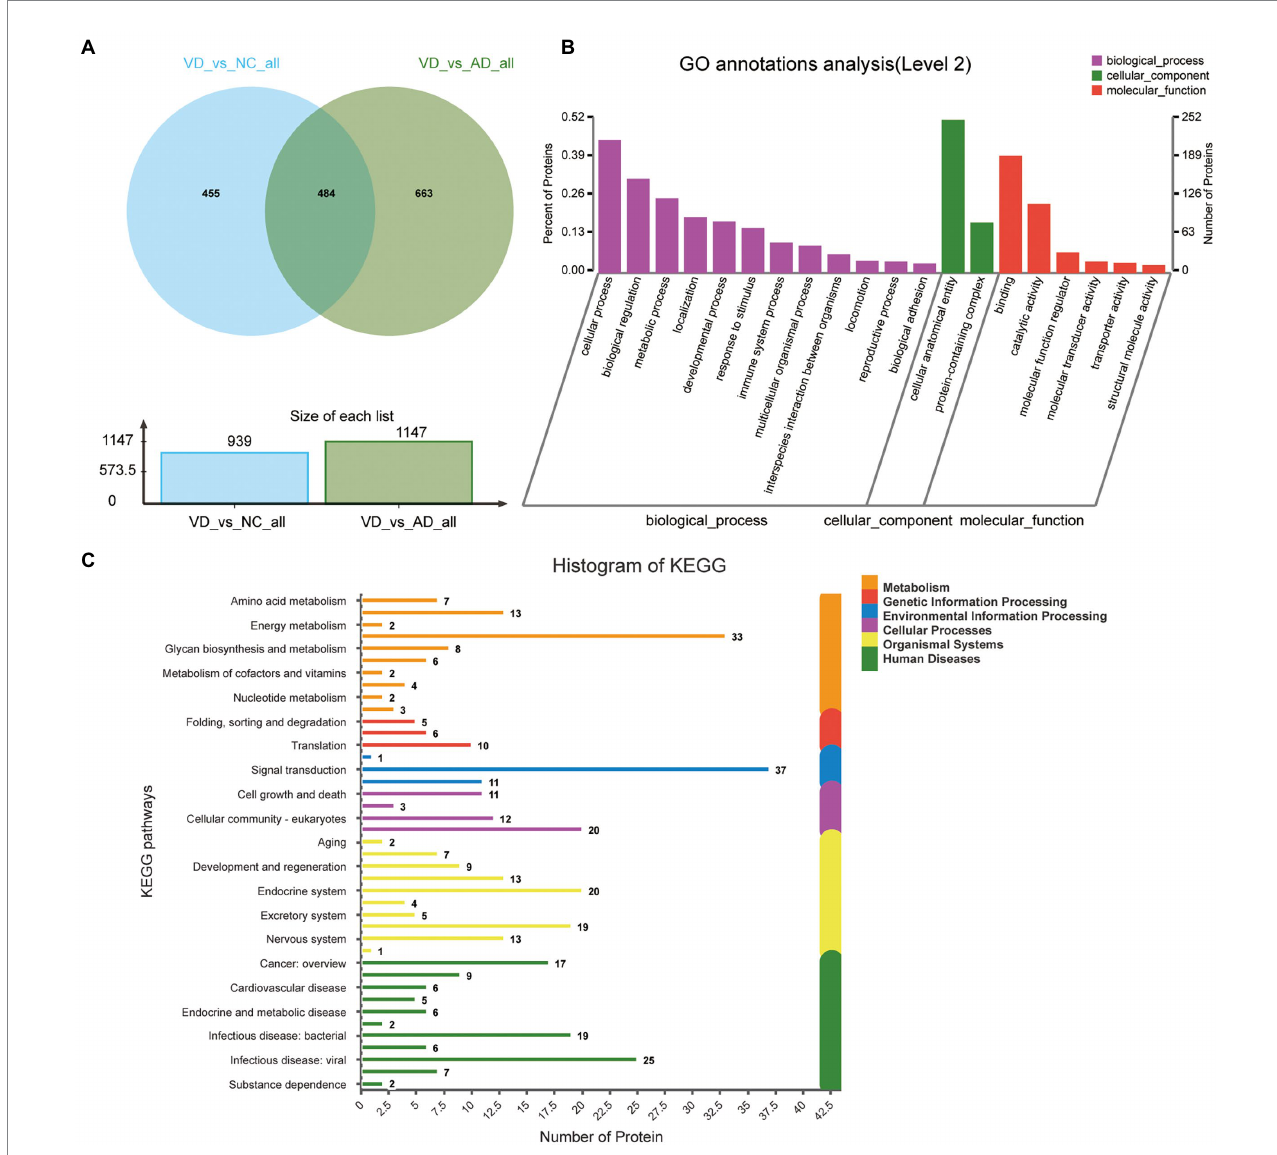
FIGURE 5 Volcano plots of quantified proteins and functional analysis of the differential expressed proteins in urine between VD and other two groups. (A) Venn chart of Urine-based Proteome analysis identified from VD vs. other two groups. (B) GO enrichment analysis of differential urine-excretory proteins. Purple bars denote the enriched biological processes, green bars are enriched cellular components, and red bars are enriched molecular functions. Protein numbers enriched in each category are presented with the bars. (C) The differential expressed proteins are associated with diseases and signal transduction pathways. The number of proteins associated with each category is